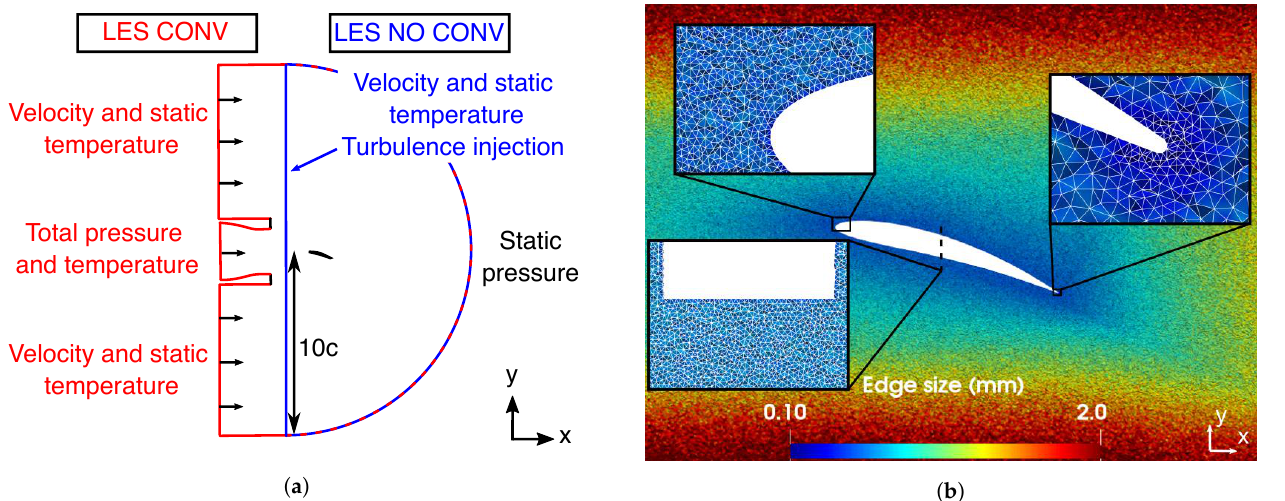
Figure 2. ( a ) Sketch of the computational domains and the boundary conditions. ( b ) Edge size of the mesh around the airfoil at z /c = 0.1 and close-ups at the airfoil leading and trailing edges and in the